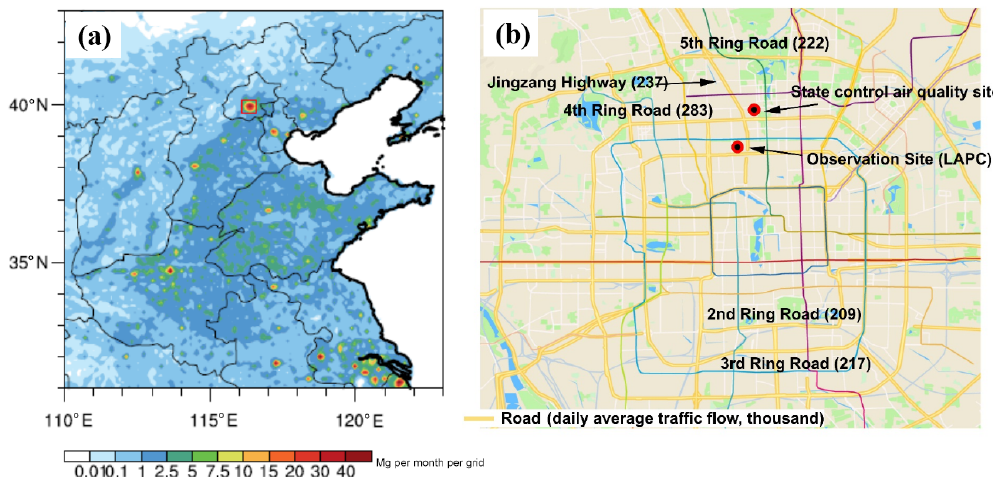
Figure 1. (a) Monthly emissions of BC from traffic in June in eastern–central China. The red box denotes the geographical location of the observation site; the map was taken from NCL software (©2019 NCL, https://www.ncl.ucar.edu, last access: 28 March 2019). (b) Road map and traffic flow rate of Beijing. The red circle denotes the observation site; the map was taken from Google Maps (©Google Maps 2019, https://www.google.com/maps, last access: 15 January 2019).